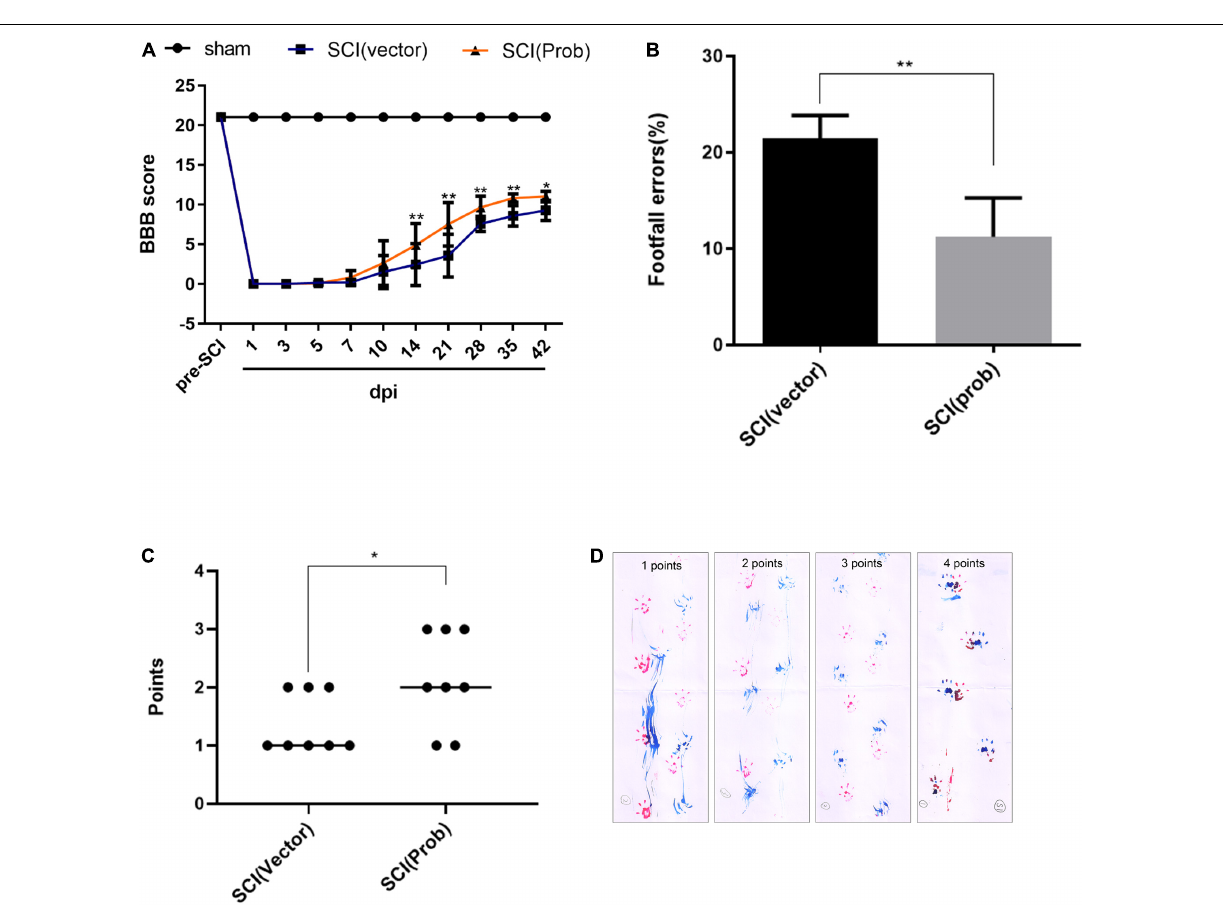
Frontiers in Molecular Neuroscience |